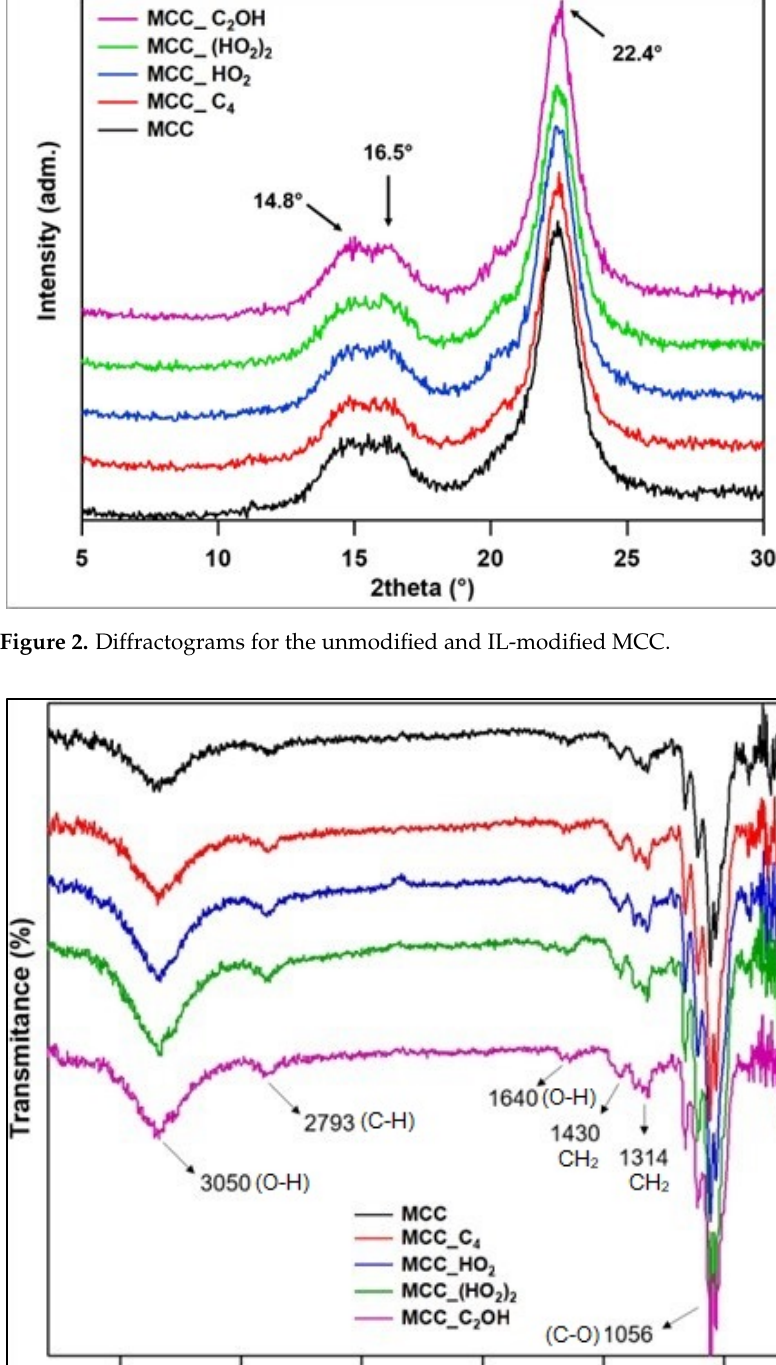
Figure 2. Diffractograms for the unmodified and IL-modified MCC.